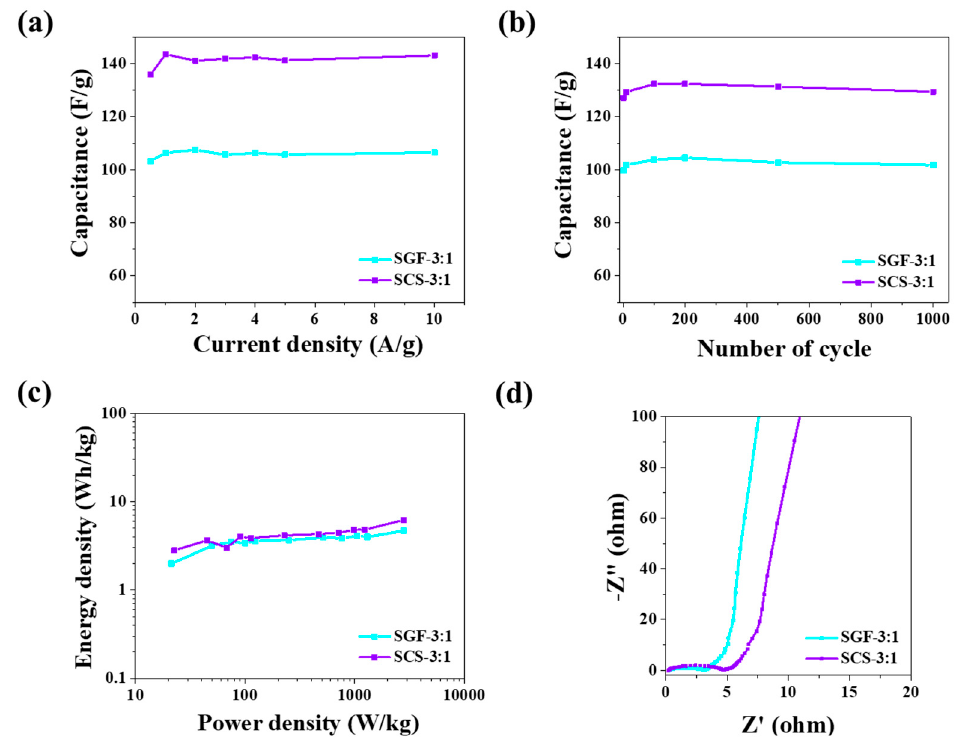
Figure 6. Electrochemical performance tests of the SCS-3:1 and SGF-3:1 samples: ( a ) specific capacitance as a function of current density; ( b ) specific capacitance as a function of cycle number; ( c ) specific capacitance as a function of power density; ( d ) Nyquist plot.